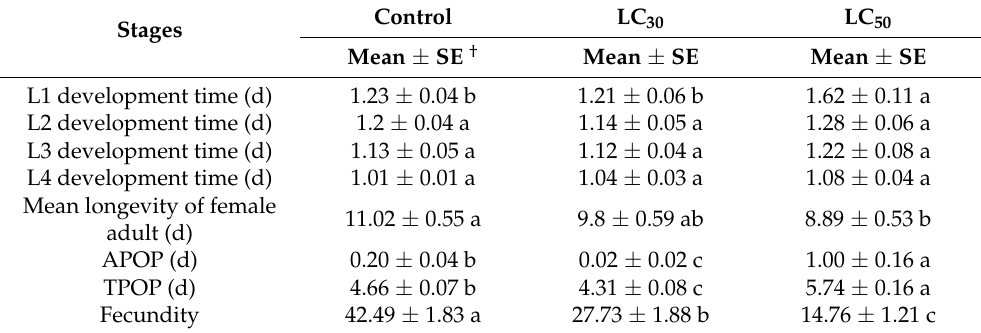
Table 2. Mean values ( ± SE) of the life–history parameters of Aphis glycines exposed to acetamiprid. Stages